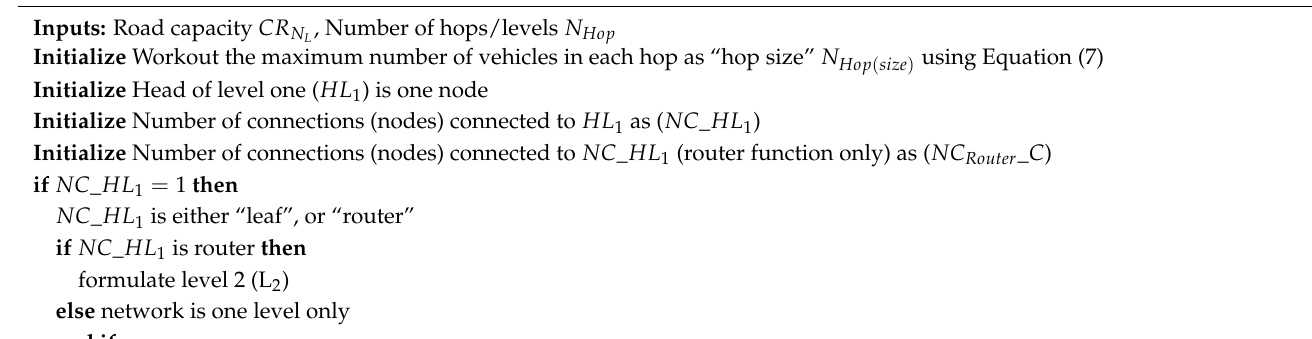
Algorithm 2 . Pseudo-code for the size of